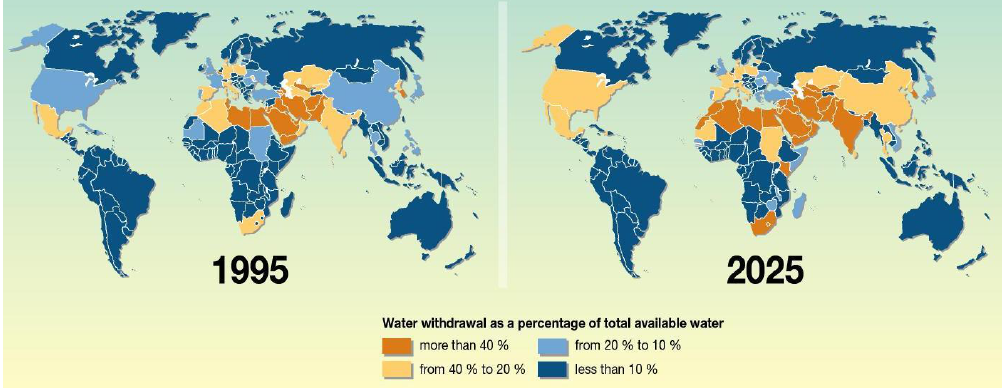
Figure 1. Water scarcity as a global challenge (more than 50% of the world countries will experience water scarcity by 2025)